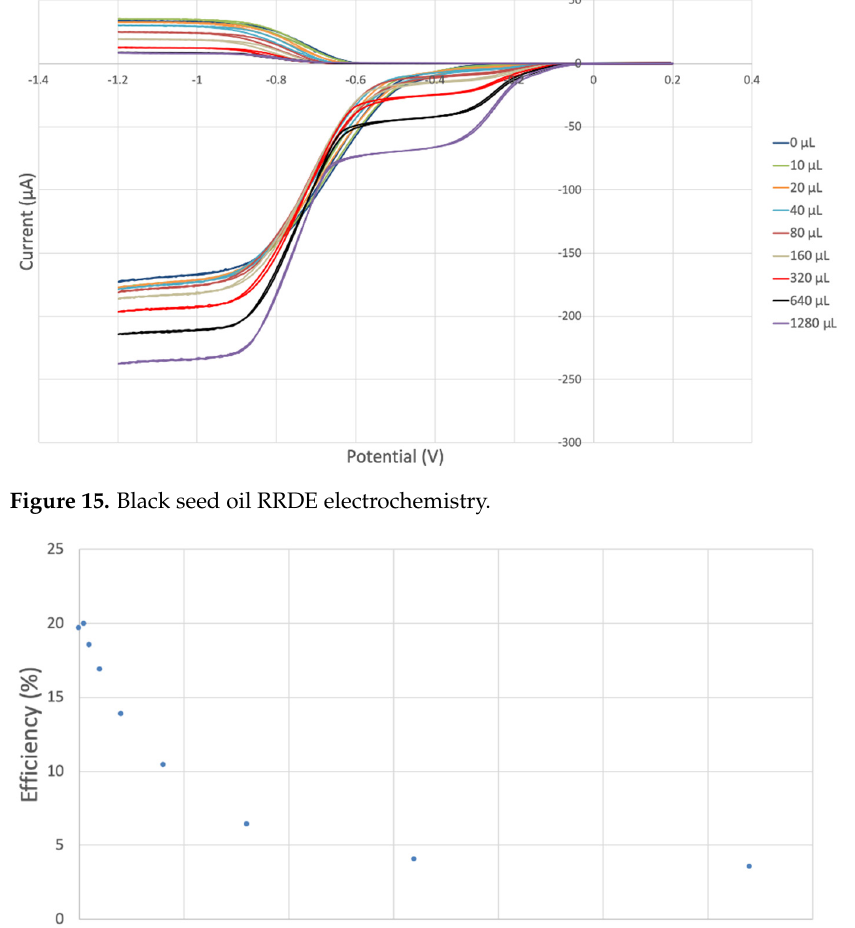
Figure 17. Black seed oil collection efficiency of blank plus first four aliquots, y = − 0.0781x + 20.08, R 2 = 0.9763.